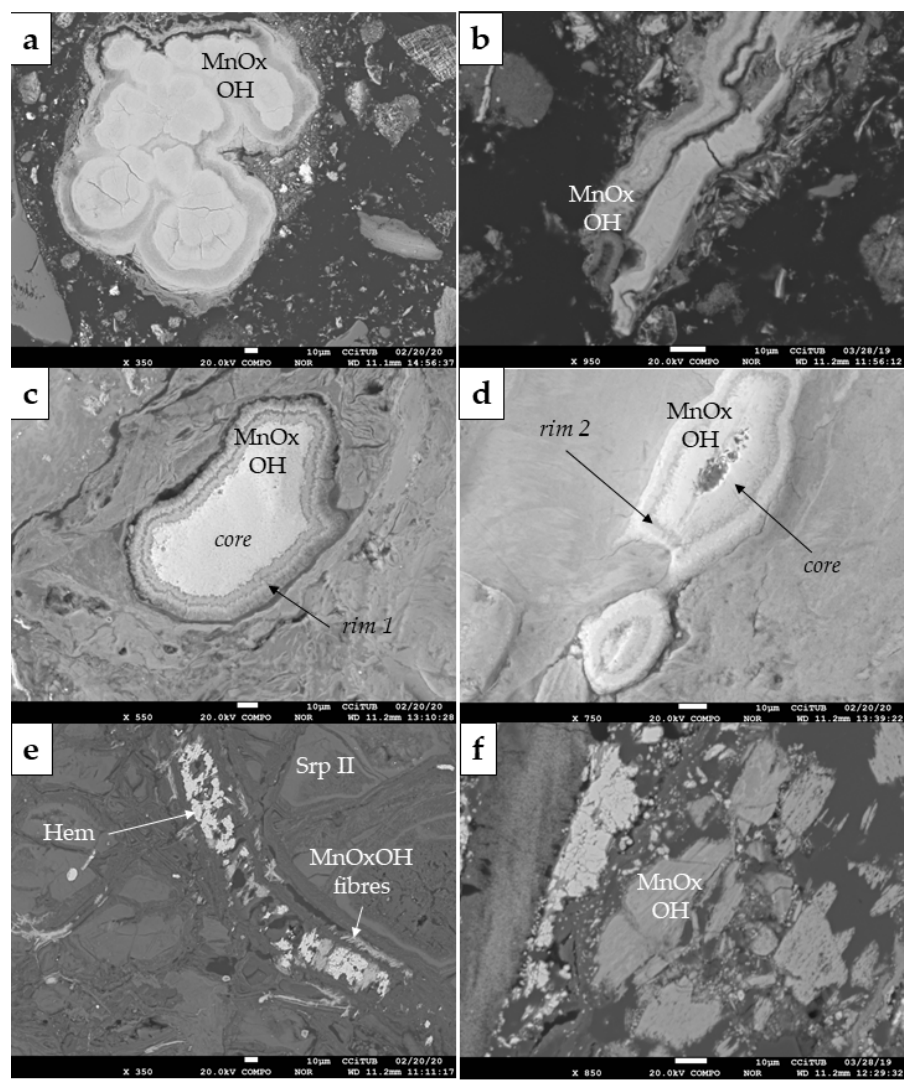
Figure 9. BSE photomicrographs of the textural features displayed by Mn-oxyhydroxides in Loma de Hierro Ni laterites (Venezuela): ( a – d ) colloform aggregates developing kidney-shaped grains ( a ), elongated grains ( b ), and sub-rounded individual grains with distinct multi-phase rims ( c , d ); ( e ) fibres within veinlets, coexisting with hematite (Hem) and secondary serpentine (Serp-II); ( f ) fragmented tabular aggregates.